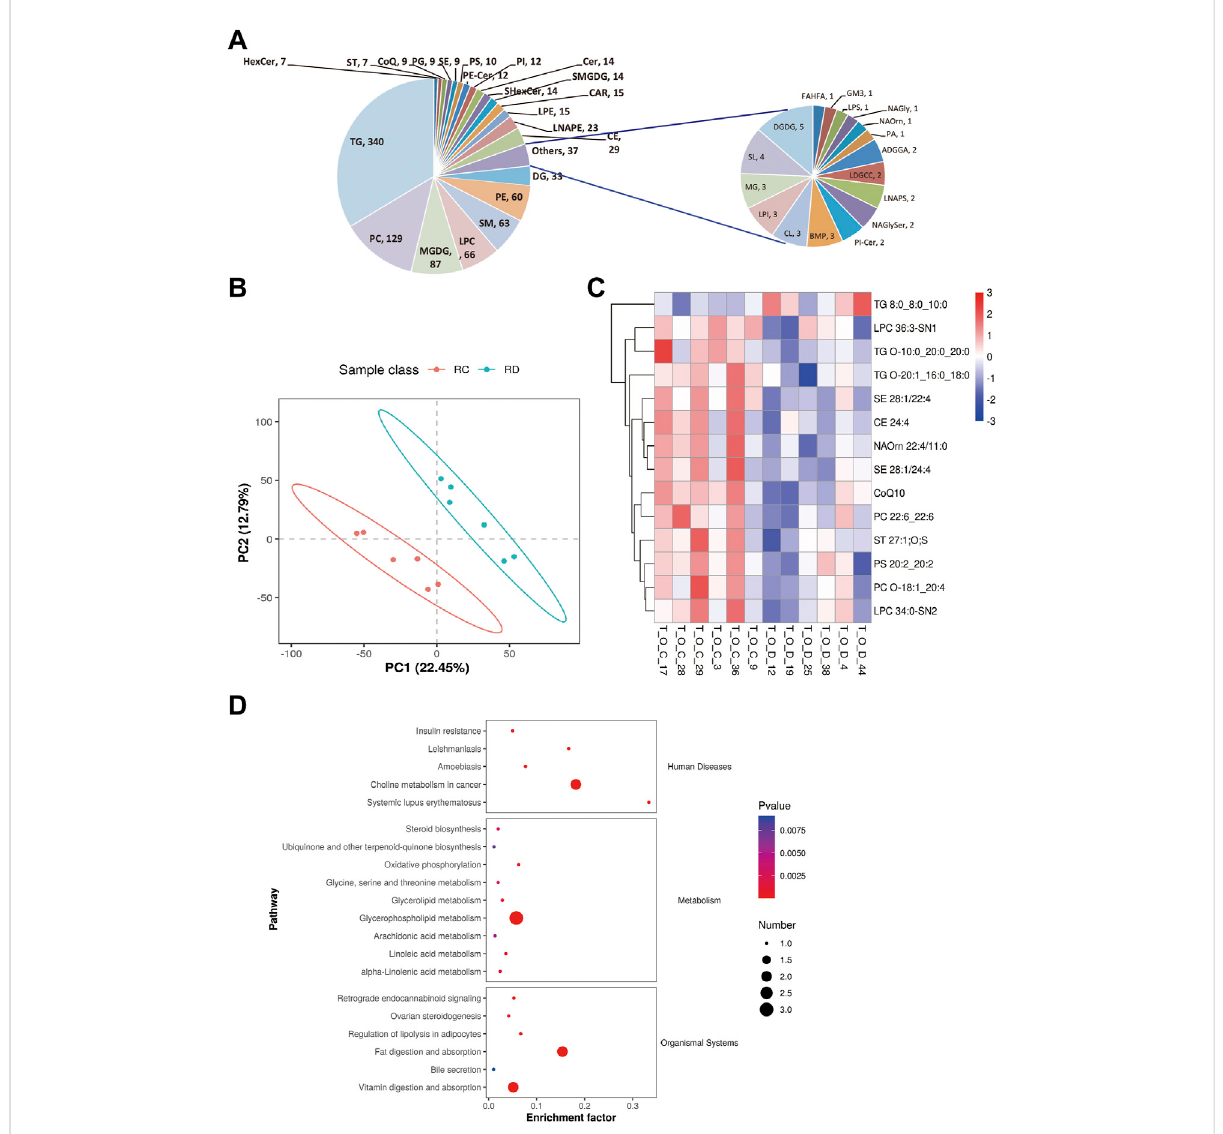
FIGURE 4 Changes in the overall lipid composition and distribution in the mouse ovary. (A) Lipids were extracted and analyzed, as described in the “ Methods ” section. Distribution of lipid classes that were considered for subsequent analysis in all of the samples detected by LC-MS/MS. (B) OPLS- DA plot of metabolomics separating depression-like and control ovarian samples. RC, control, and RD, depression-like. (C) Heat maps of differentially expressed metabolites in the ovaries of depression-like mice were signi fi cantly changed compared with control. T_O_C, control and T_O_D, depression-like. (D) KEGG enrichment analysis of differential metabolite changes in depression-like mice compared with control. Four ovaries in each group were